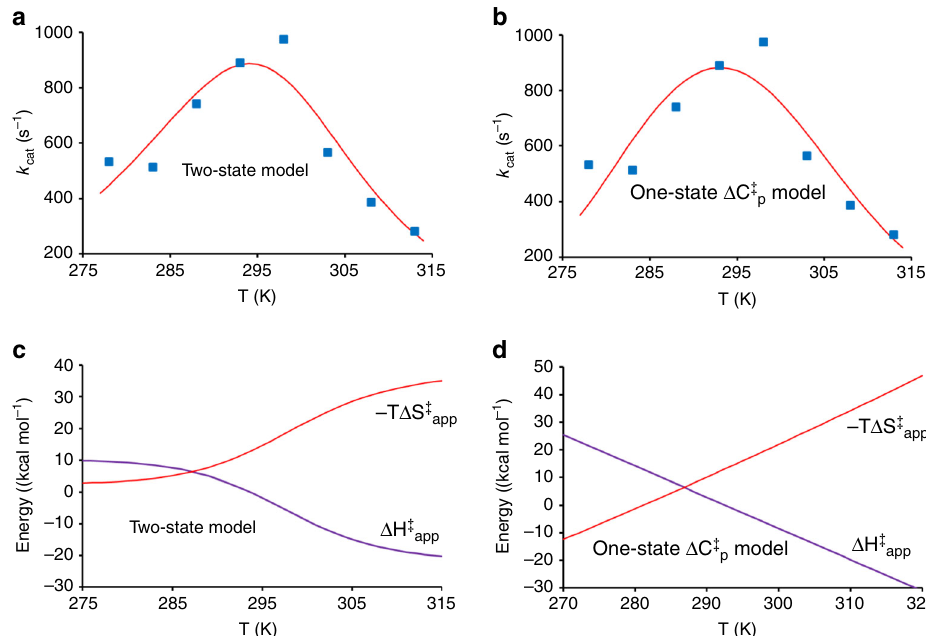
Fig. 6 Kinetic models for the anomalous temperature dependence of AHA. a Fit of the two-state dead-end model to the calculated values of k cat for the psychrophilic enzyme and ( b ) the corresponding fi t of the heat capacity model to the same data points. Predictions of the two-state ( c ) and heat capacity ( d ) models of the temperature dependence of the apparent activation enthalpy and entropy contributions to the free energy